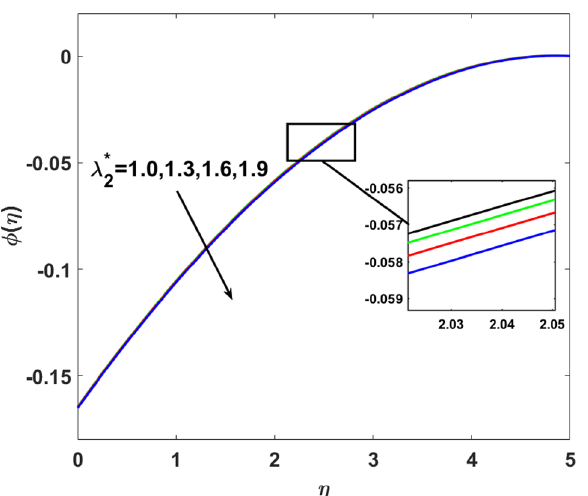
Figure 17. φ(η) versus (cid:31) ∗ 2